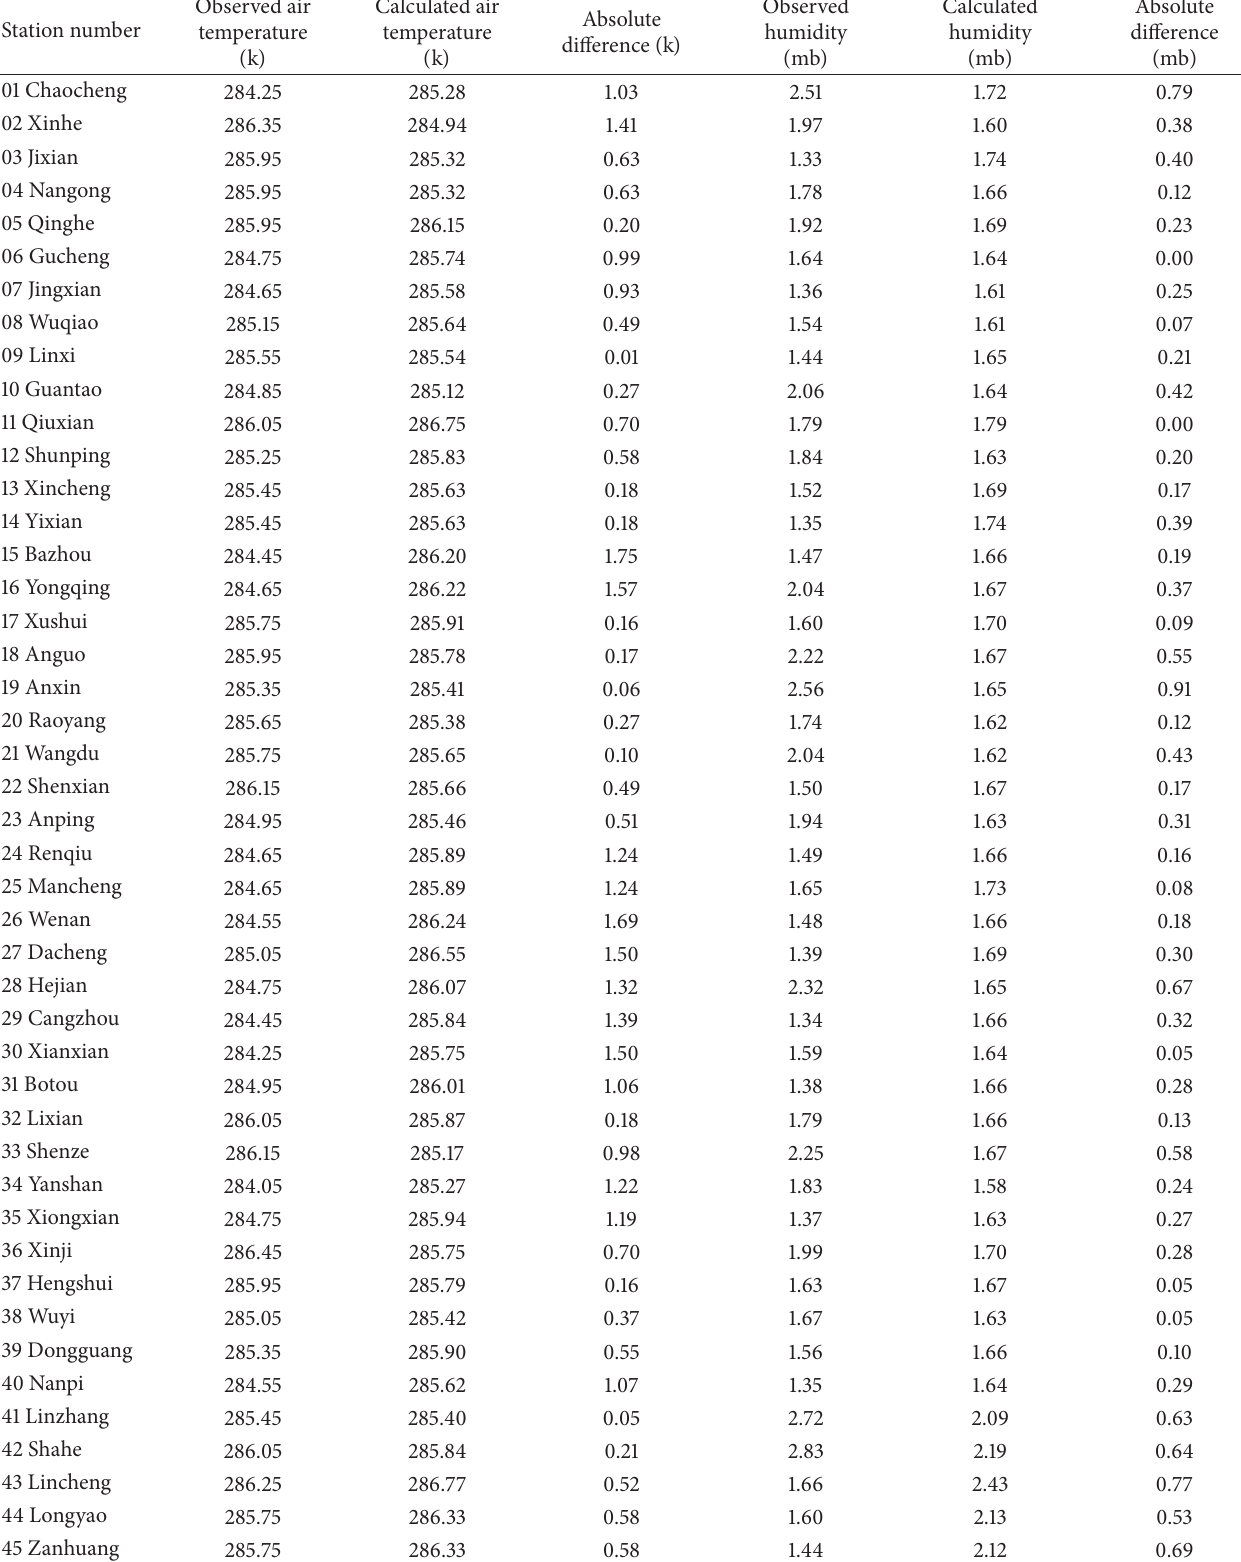
Table 1: Comparison of the calculated value of air temperature and humidity model of North China Plain and the actual observed